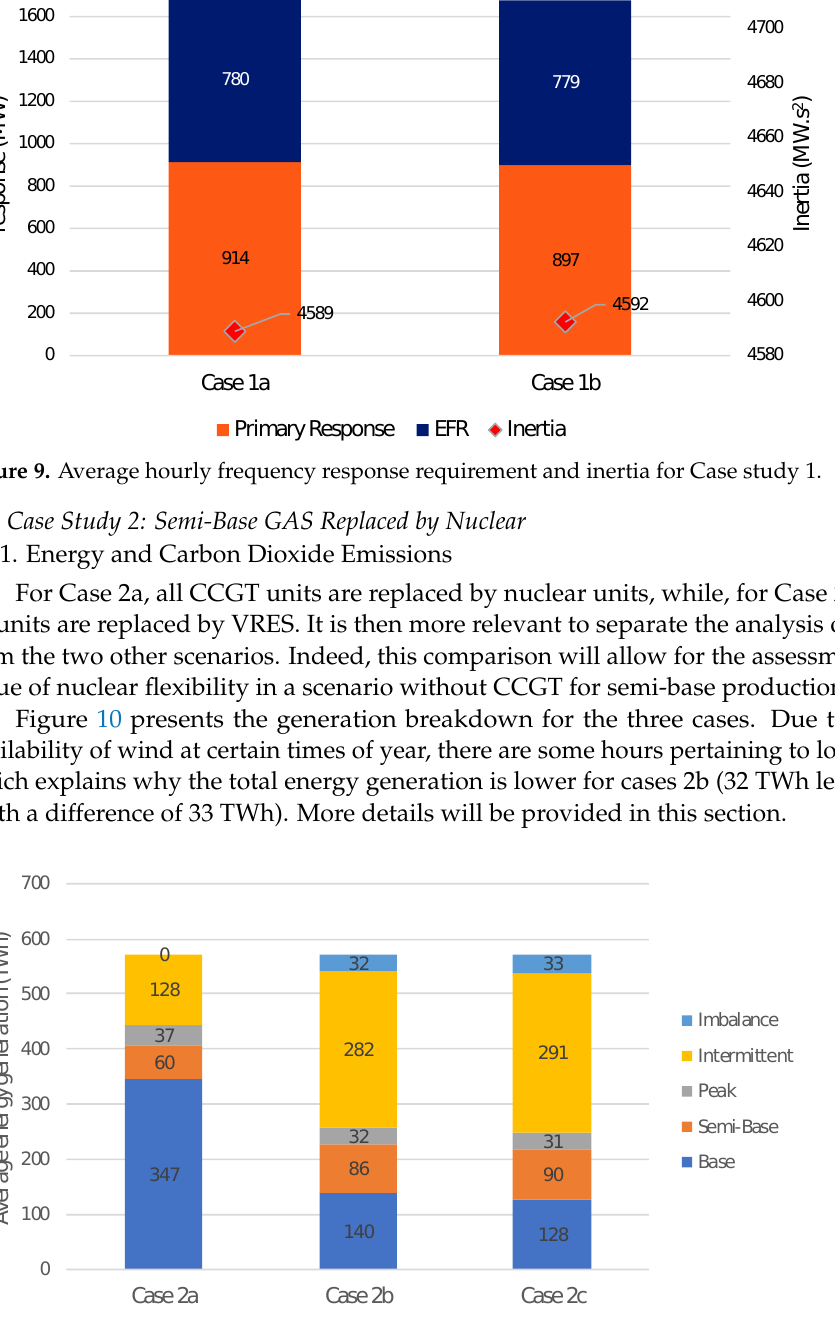
Figure 10. Average generation breakdown for Case study